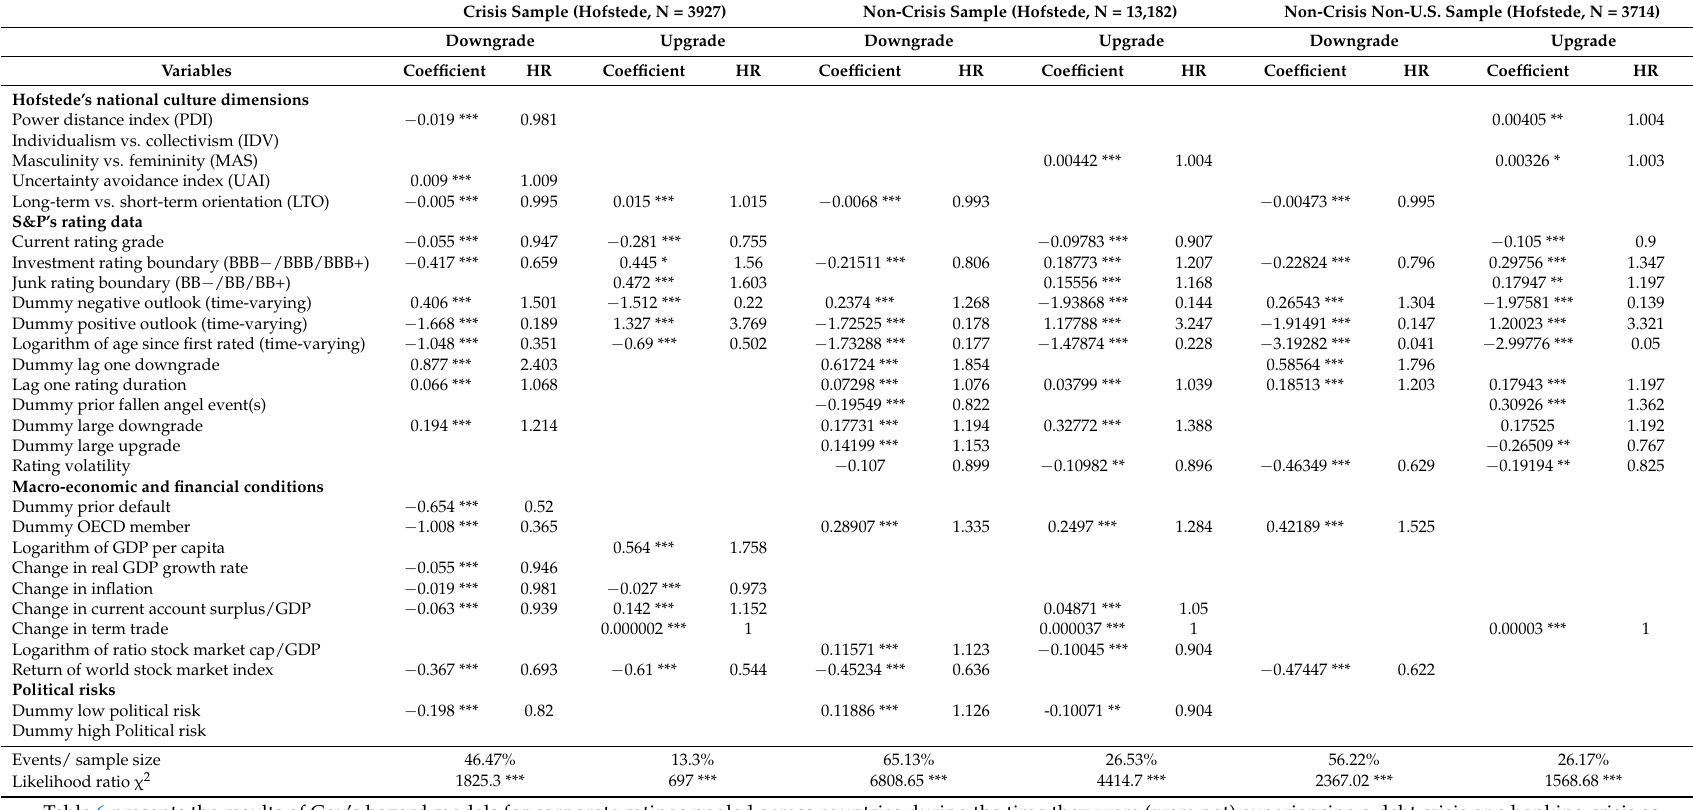
Table 6. Cox’s regression model for corporate rating changes: crisis vs. non-crisis